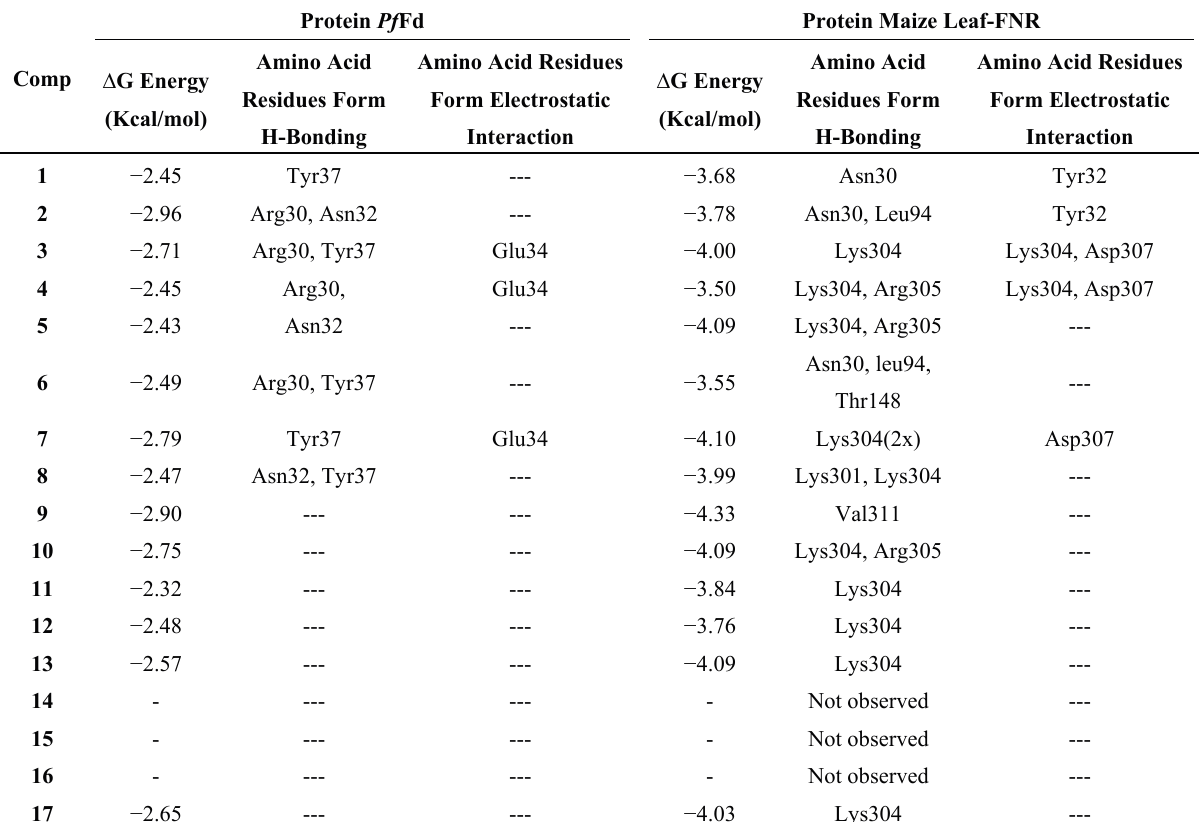
Table 3. The docking results of synthesized compounds into Pf Fd and